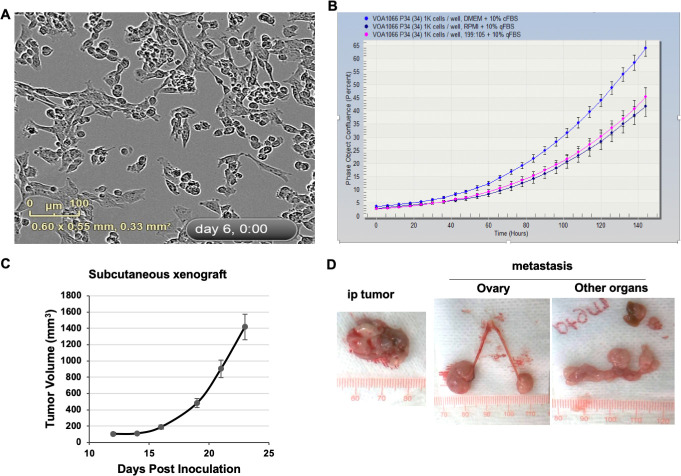
The proliferation and morphology of VOA1066 cells in vitro and in vivo.(A) A representative image of VOA1066 cells on petri dish. (B) Growth curves of VOA1066 in different culture media. (C) Subcutaneous tumor growth curve of VOA1066 cells. (D) Representative images of intraperitoneal xenografted tumors and their metastasis of VOA1066 cells.